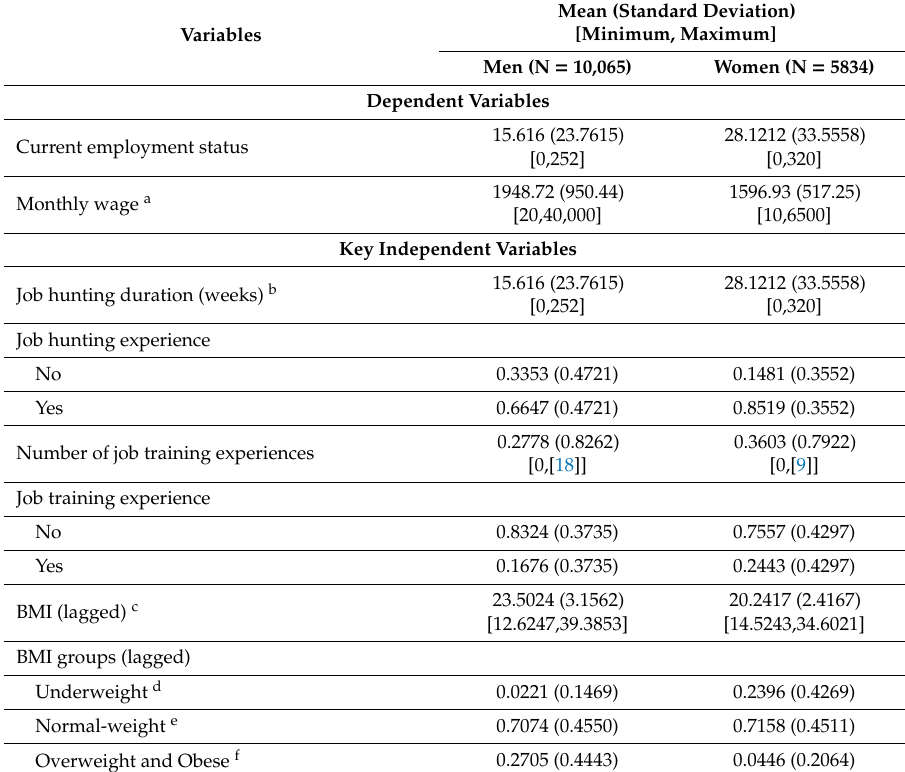
Figure 1. A flowchart demonstrating the obtained final sample used for the study. Note: a This sample was used to assess the respondents’ current employment status, key independent variables, and covariates, as seen on Table 1. b This final sample of wage-earners was used to assess the respondents wage levels to analyze the moderating effects of job hunting and job training in the labor market. Table 1. Descriptive statistics (whole sample: N = 15,899).